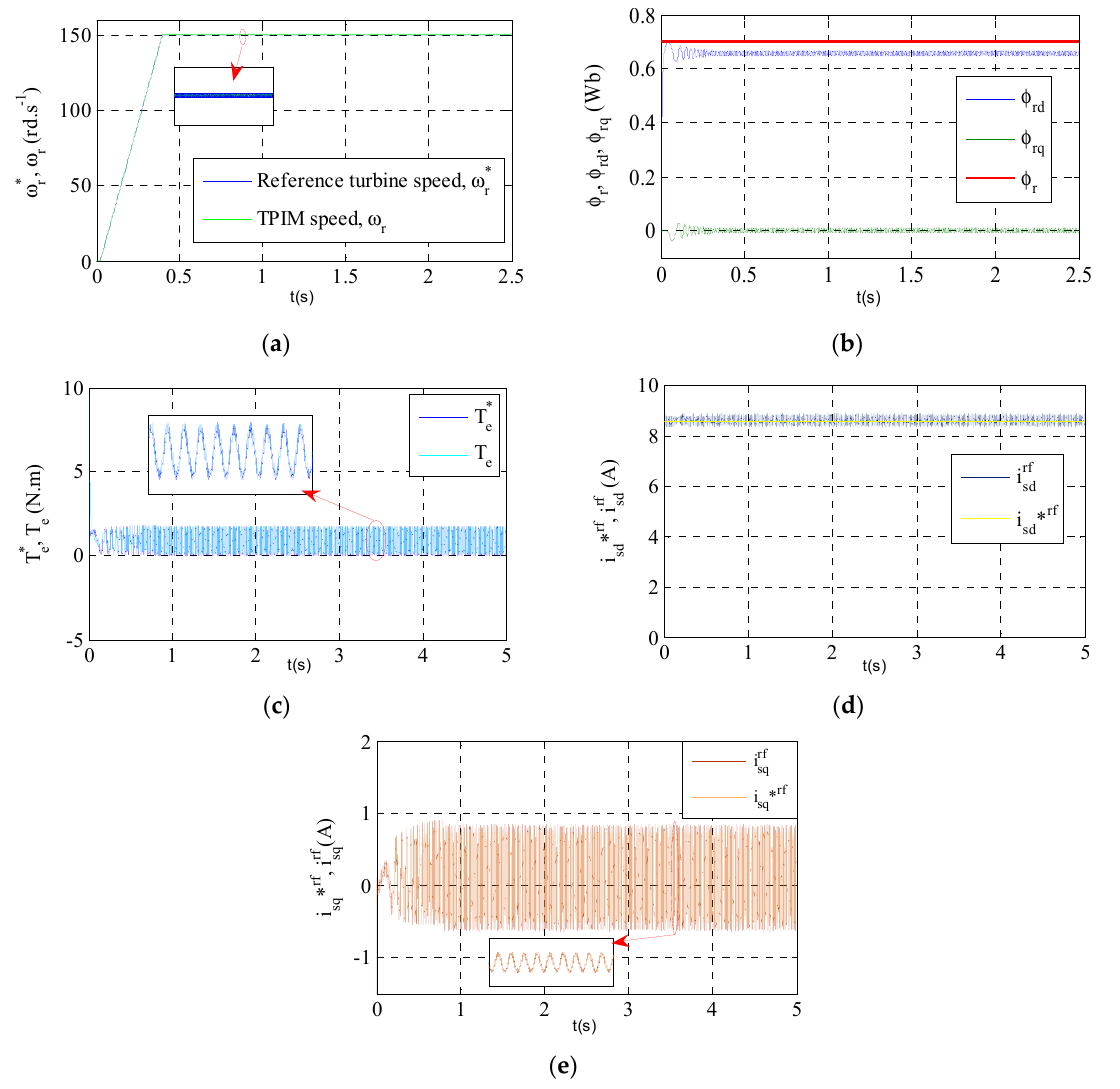
Figure 11. Simulation results of IRFOC no-loaded TPIM drive fed by an advanced SVM controlled 2 ϕ -inverter under linear constant wind speed profile: ( a ) turbine and TPIM speeds; ( b ) rotor fluxes; ( c ) reference and TPIM electromagnetic torques; ( d ) d-axis reference and actual stator currents and ( e ) q-axis reference and actual stator currents.